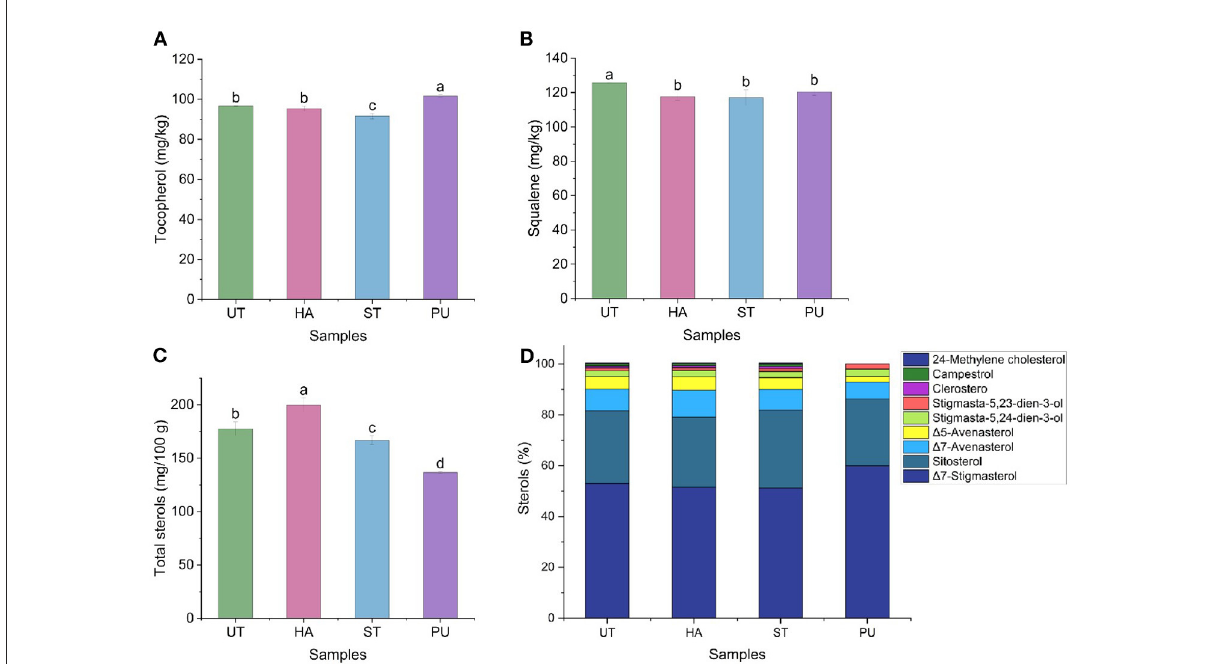
FIGURE6 The contents of tocopherols, squalene, and sterols of camellia oil from untreated and HA, ST, PU pretreated camellia seeds [ (A) tocopherol, (B) squalene, (C) total sterols, (D) single sterols]. Bars with no letter in common are significant different ( P <